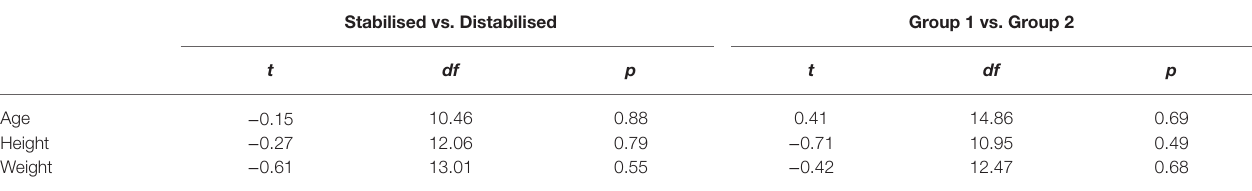
TABLE 2 | Statistical results of comparing participants’ age, height, and weight based on stabilization and clustering categorization. Stabilised vs.